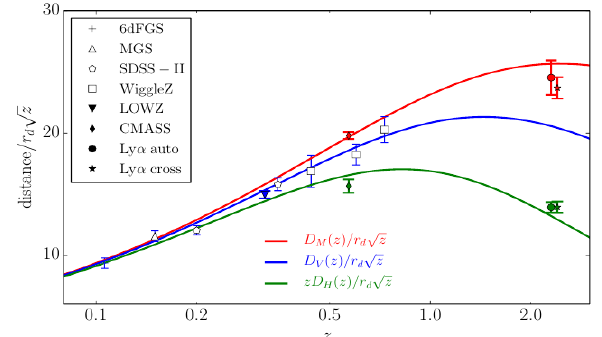
Figure 13. BAO Hubble diagram. BAO measurements of D V / r d , D M / r d , and zD H / r d from the sources indicated in the legend. The scaling factor √ z is included for a better display of the error bars. Solid lines are plotted by using the best-fit values obtained by the Planck satellite [85]. The Ly α cross-correlation points have been shifted in redshift; auto-correlation points are plotted at the correct effective